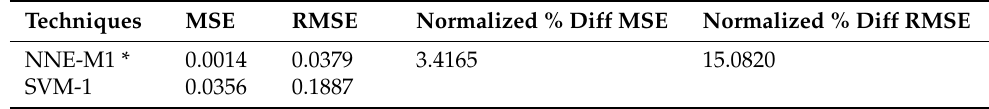
Table 4. Comparison of the best single model and ensemble for TDS.